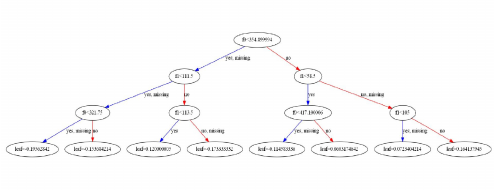
Figure 7.The result of the model of grid search method